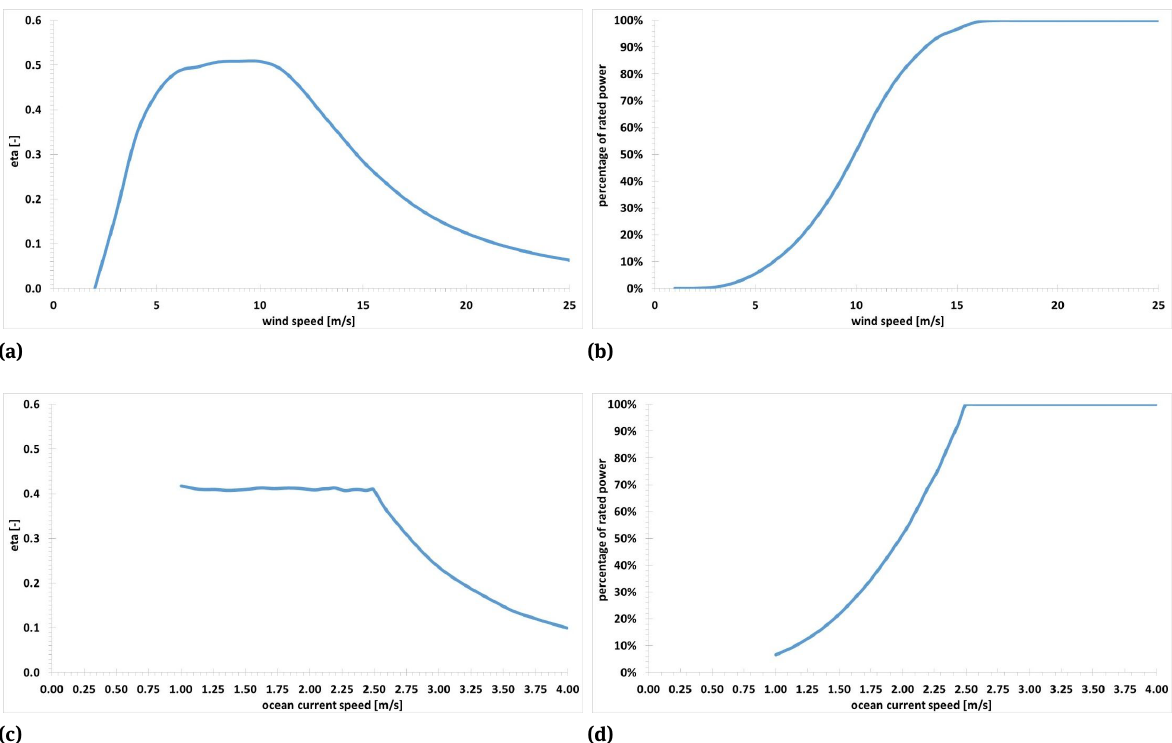
Figure 2: a) and b) Experimental power coefficient and power curve of a 900-kW wind turbine Enercon E-44. The rotor number is 1, the blade number per rotor is 3, the rotor diameter is 44 m. Hub height is 45/55 m. The power coefficients are computed from the power and speed data proposed in [20]. c) and d) Experimental power coefficient and power curve of an ocean current turbine SeaGen-S 2 MW. The number of rotors is 2, the blade number per rotor is 2, the rotor diameter is 20 m. The power coefficients are computed from the power and speed data proposed in [29]. Table 2: Performance characteristics of industrialized large marine current turbines